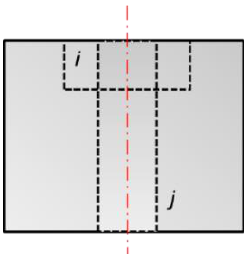
Figure 1. Illustrative representation of precedence drilling